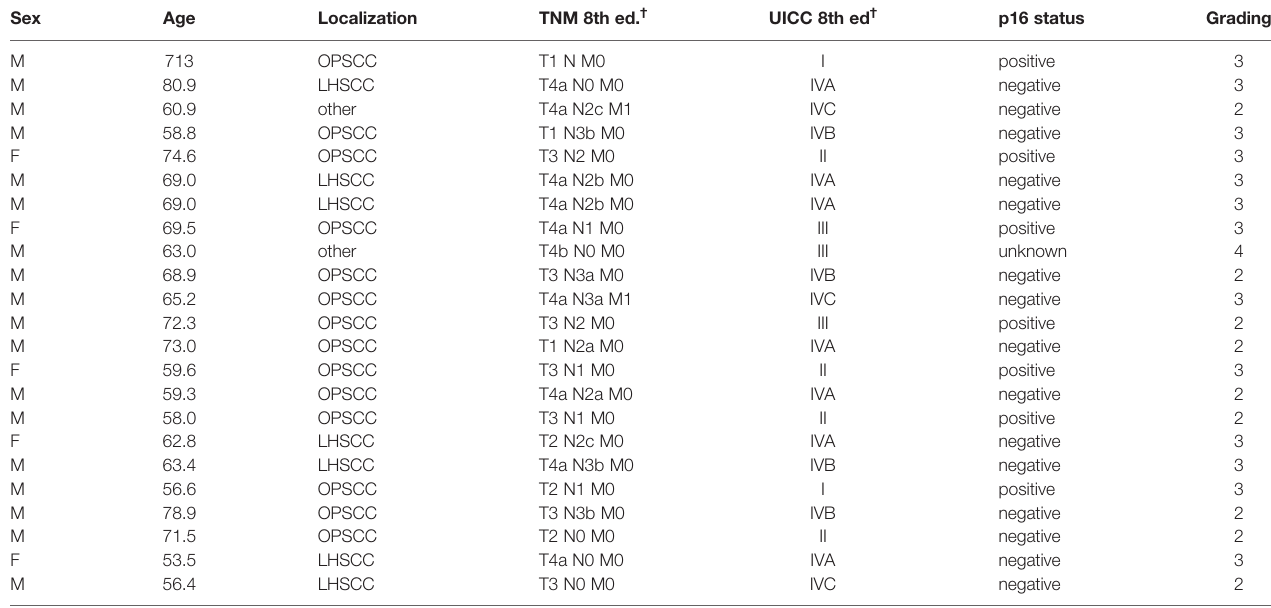
TABLE 1 | Characteristics of the HNSCC samples investigated in the FLAVINO